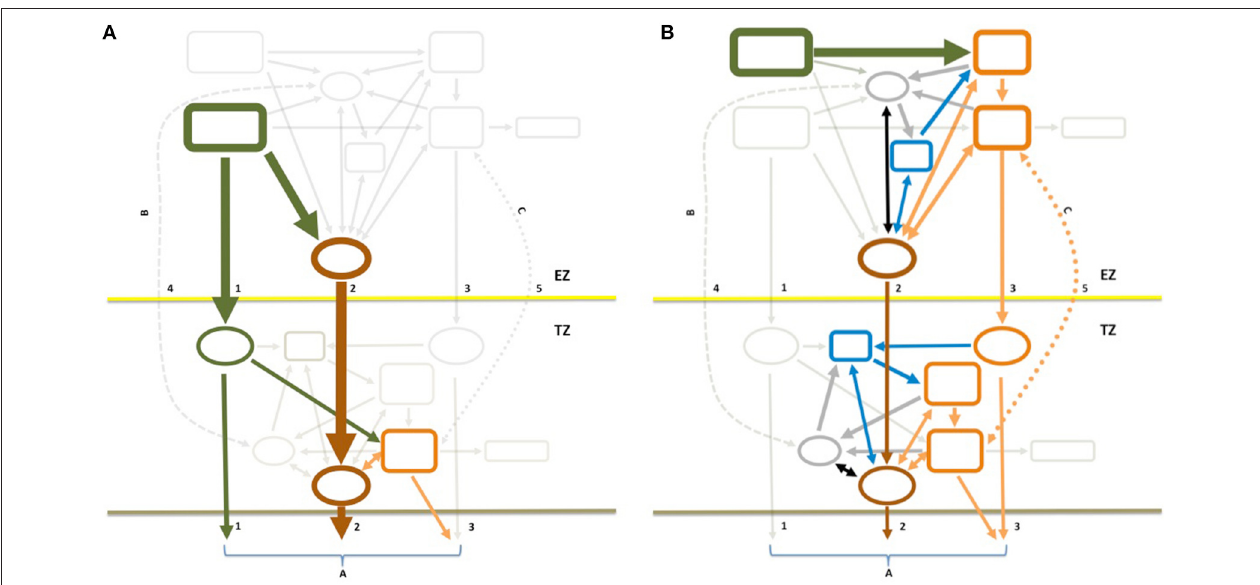
FIGURE 5 | Conceptual wiring diagrams for (A) the spring bloom in the North Atlantic and (B) summer conditions in the North Pacific. These figures follow the organization of the EXPORTS wiring diagram presented in Figure 4